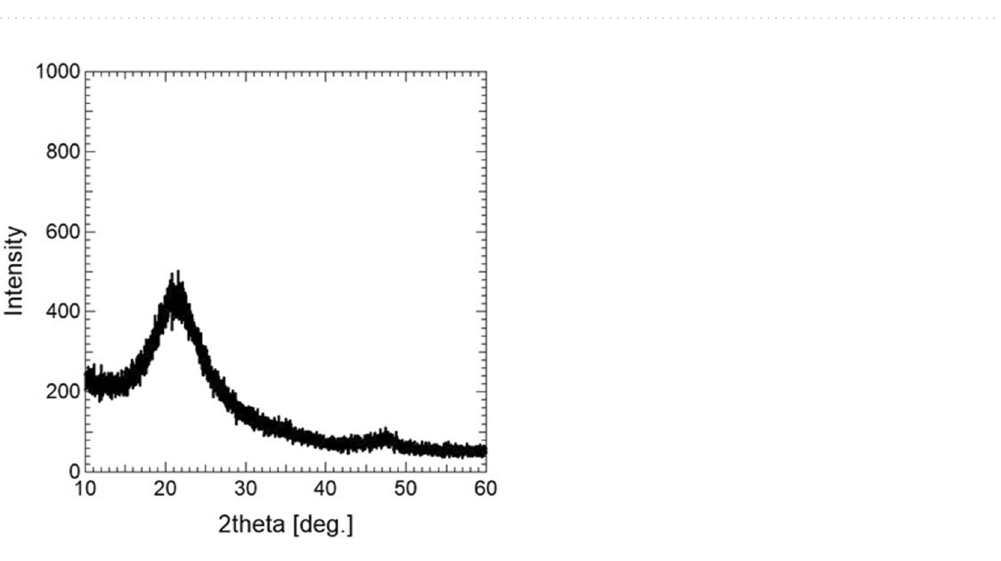
Figure 6. Comparison of the bond strengths of different Al 2 O 3 samples.